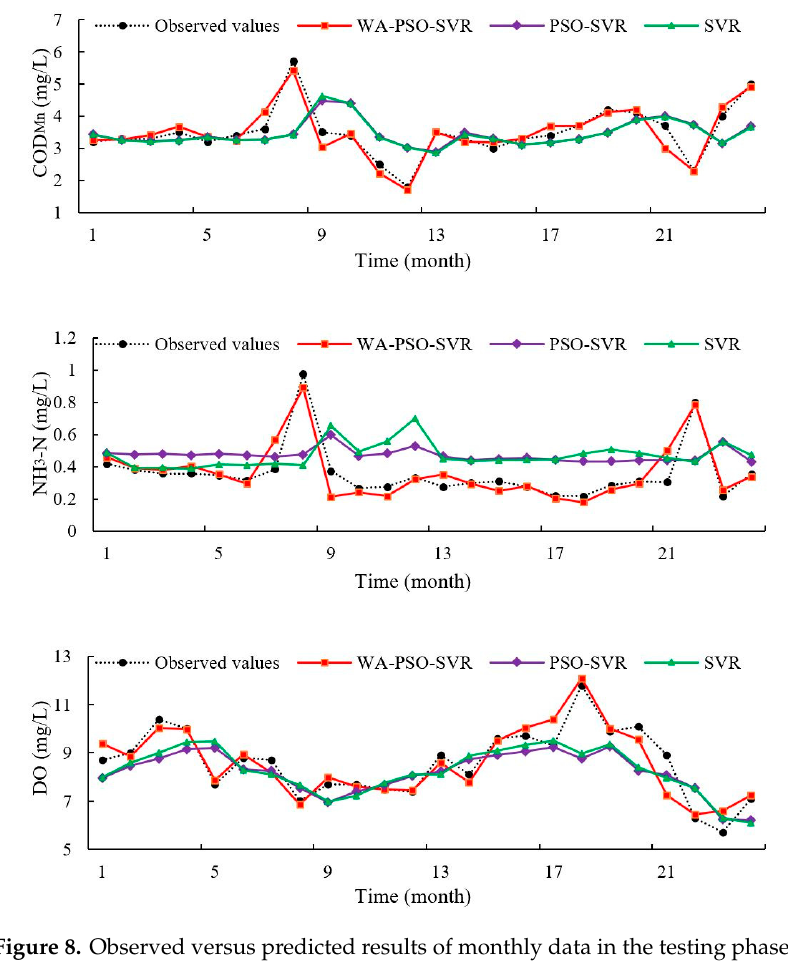
Figure 8. Observed versus predicted results of monthly data in the testing phase. Water 2020 , 12 , x FOR PEER REVIEW